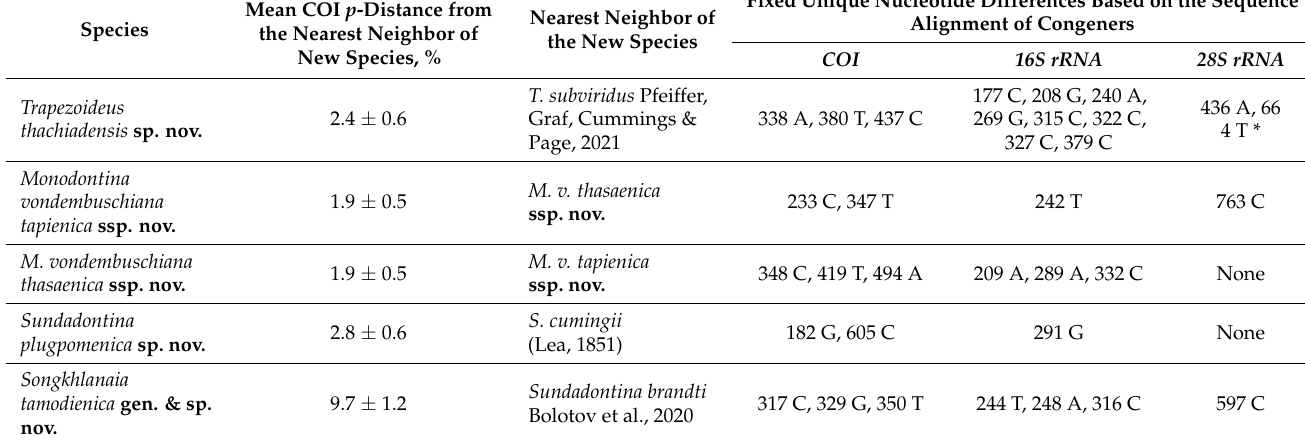
Table 2. Molecular diagnoses of the new freshwater mussel species and subspecies (Unionidae) from Southern